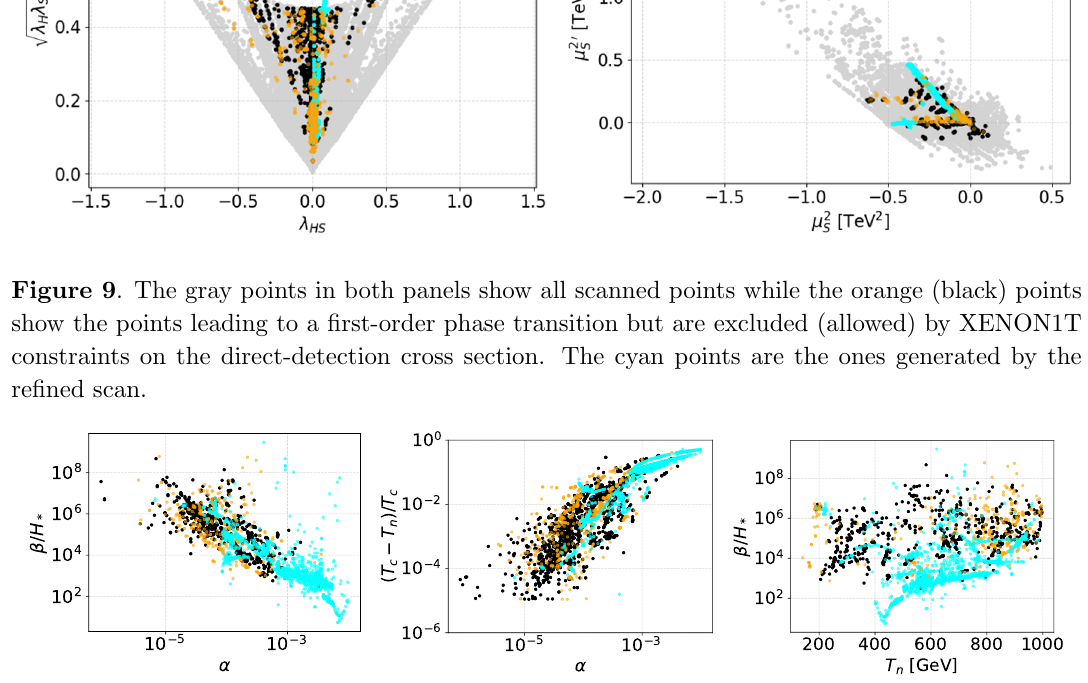
Figure 10 . All points leading to a (cid:12)rst-order phase transition including the points from the re(cid:12)ned scan shown in cyan. The orange (black) points are excluded (allowed) by the XENON1T experiment. Left panel: (cid:12)=H n vs. (cid:11) at nucleation temperature. Middle panel: ( T c (cid:0) T n ) =T c vs. (cid:11) . Right panel: (cid:12)=H n vs. T n